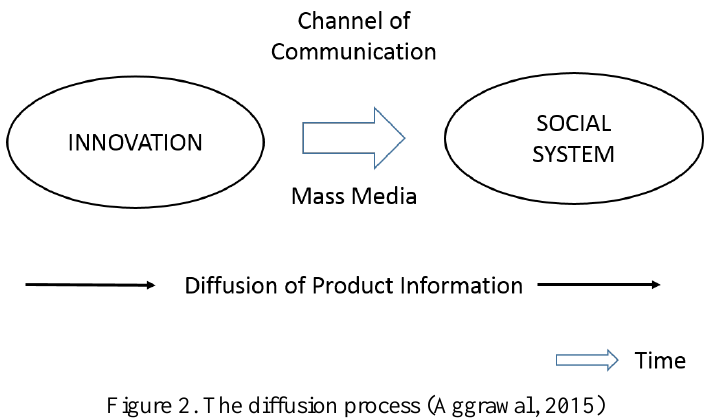
Figure 2. The diffusion process (Aggrawal,